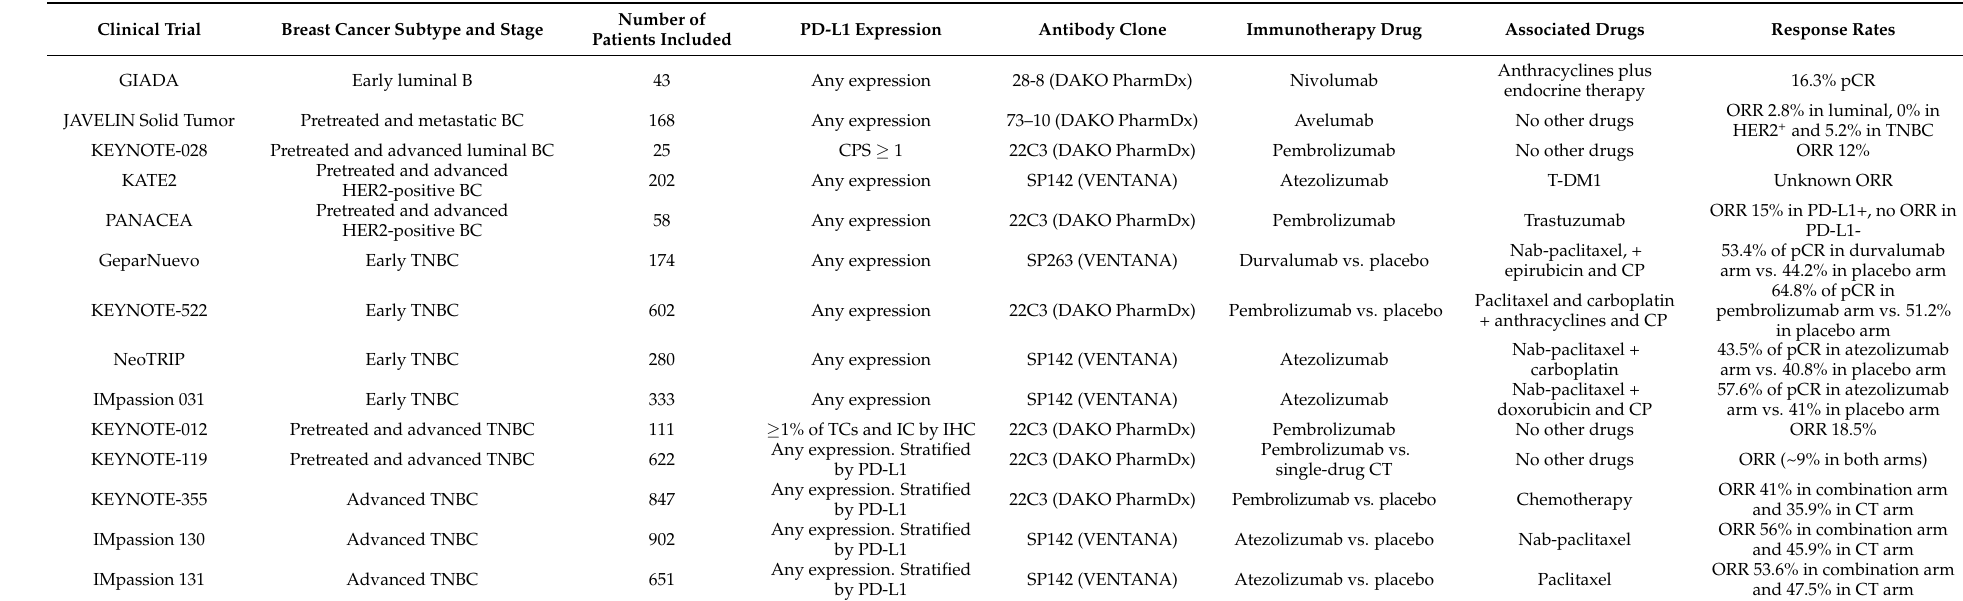
Table 3. Summary of the most relevant studies with immunotherapy in the different subtypes of breast